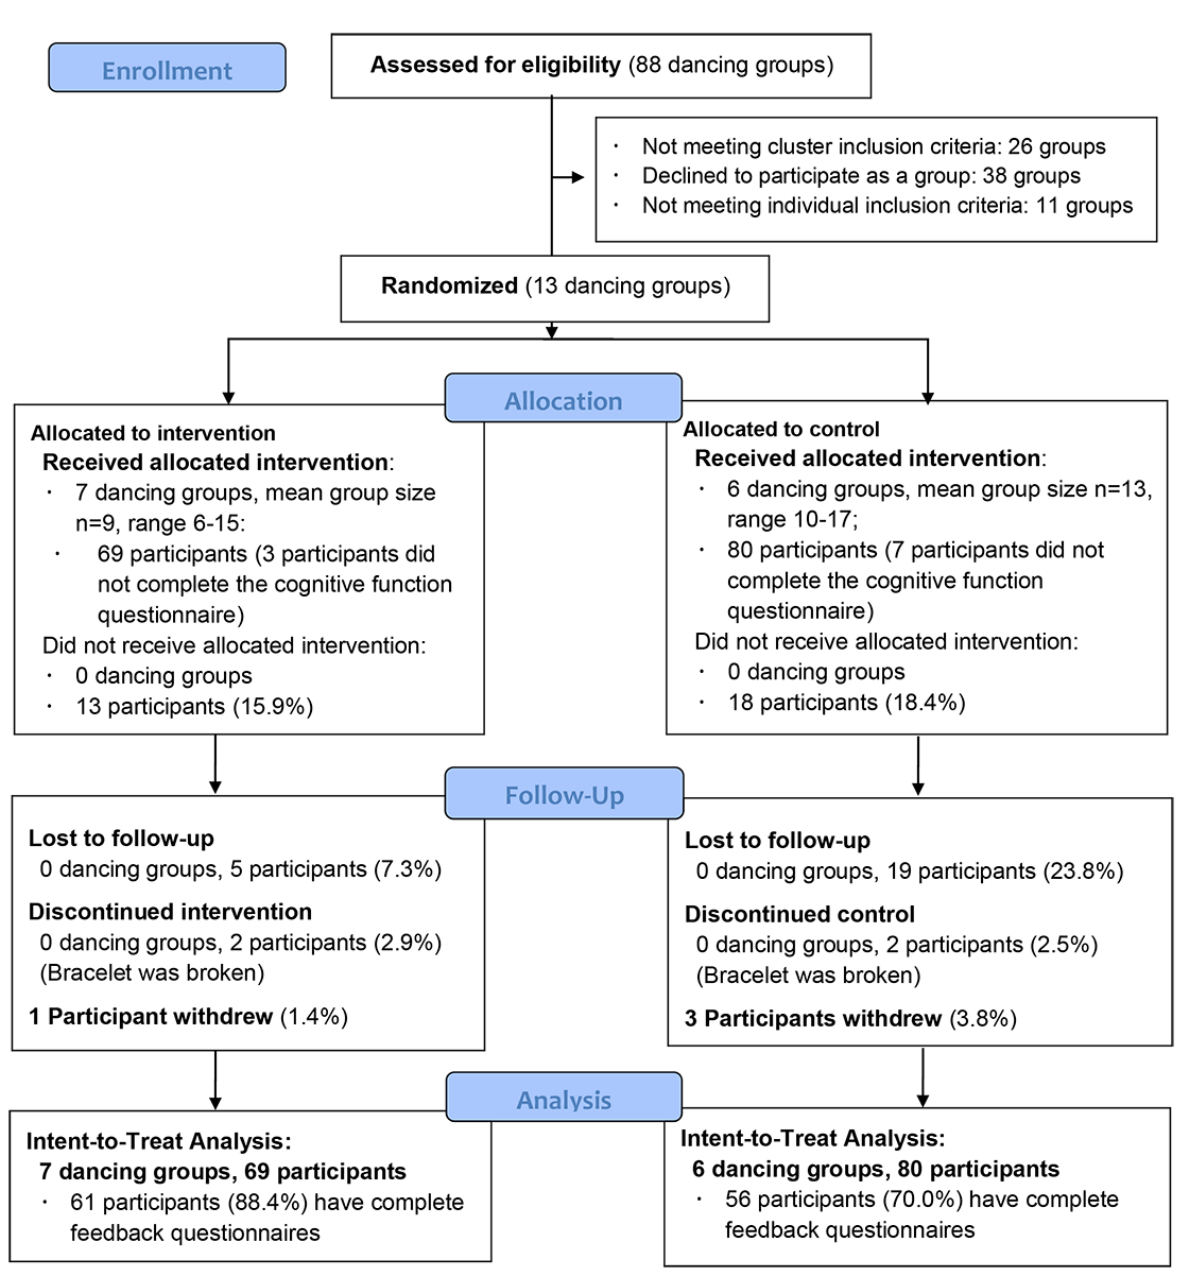
Figure 2. The flowchat of participants